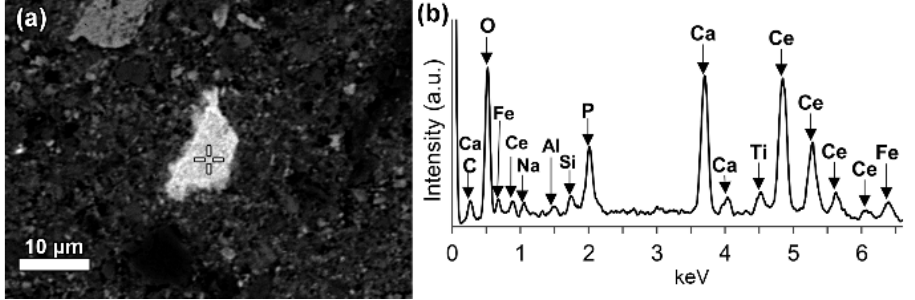
Figure 6. Cerium phosphate in bauxite residue matrix, shown on ( a ) backscattered electron image with its ( b ) EDS spectrum.